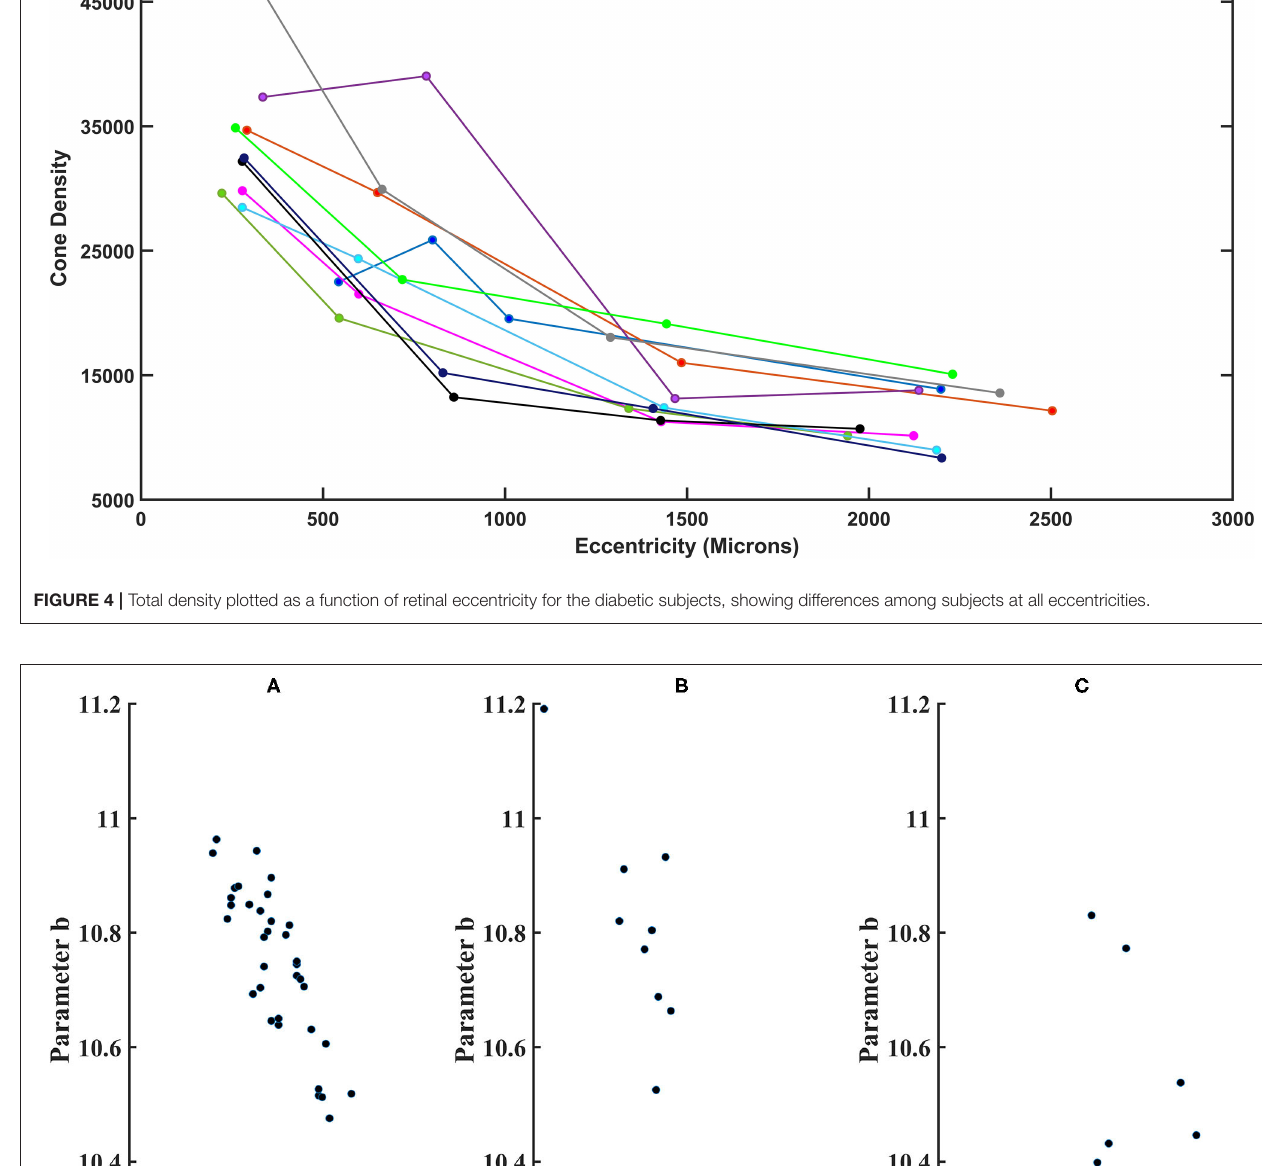
of the 36 younger subjects and the same older subjects (17) and in 36 younger subjects (19). However, the greater variability of the older subjects may be in part due to a smaller sample size.